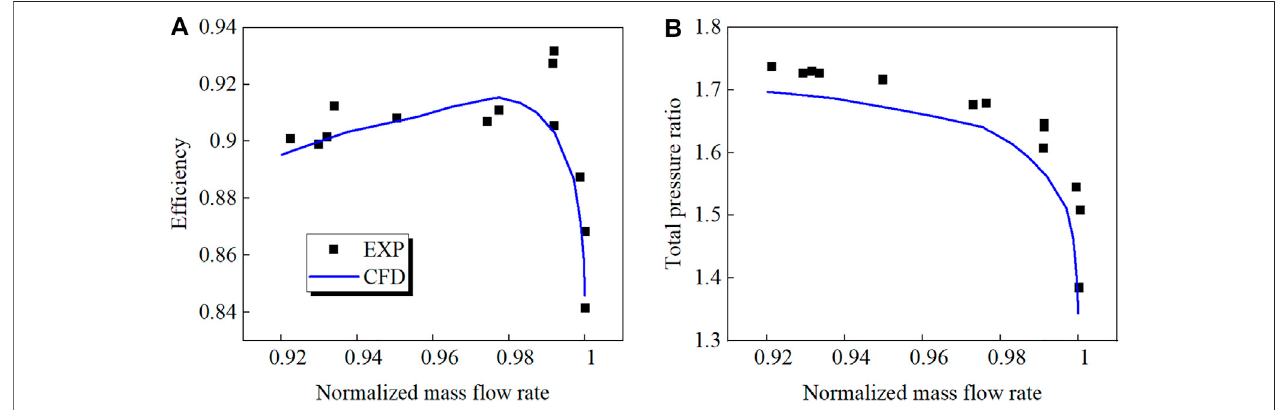
FIGURE 4 | Comparison of measured and predicted characteristic lines. (A) Ef fi ciency (B) Total pressure